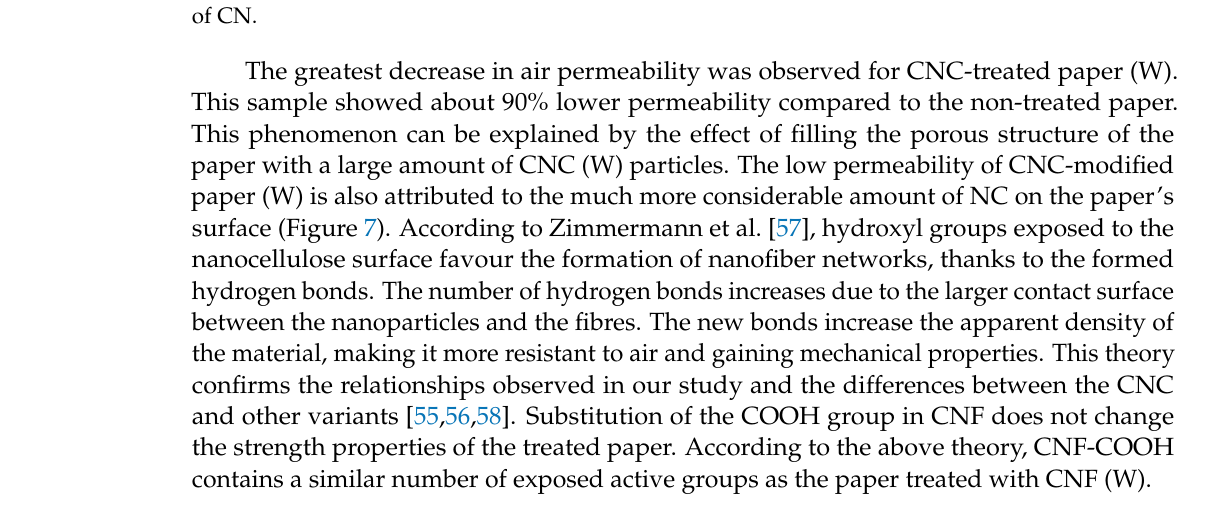
Figure 8. Surface roughness ( a ) and air permeability ( b ) of WBP treated with different preparations of CN.